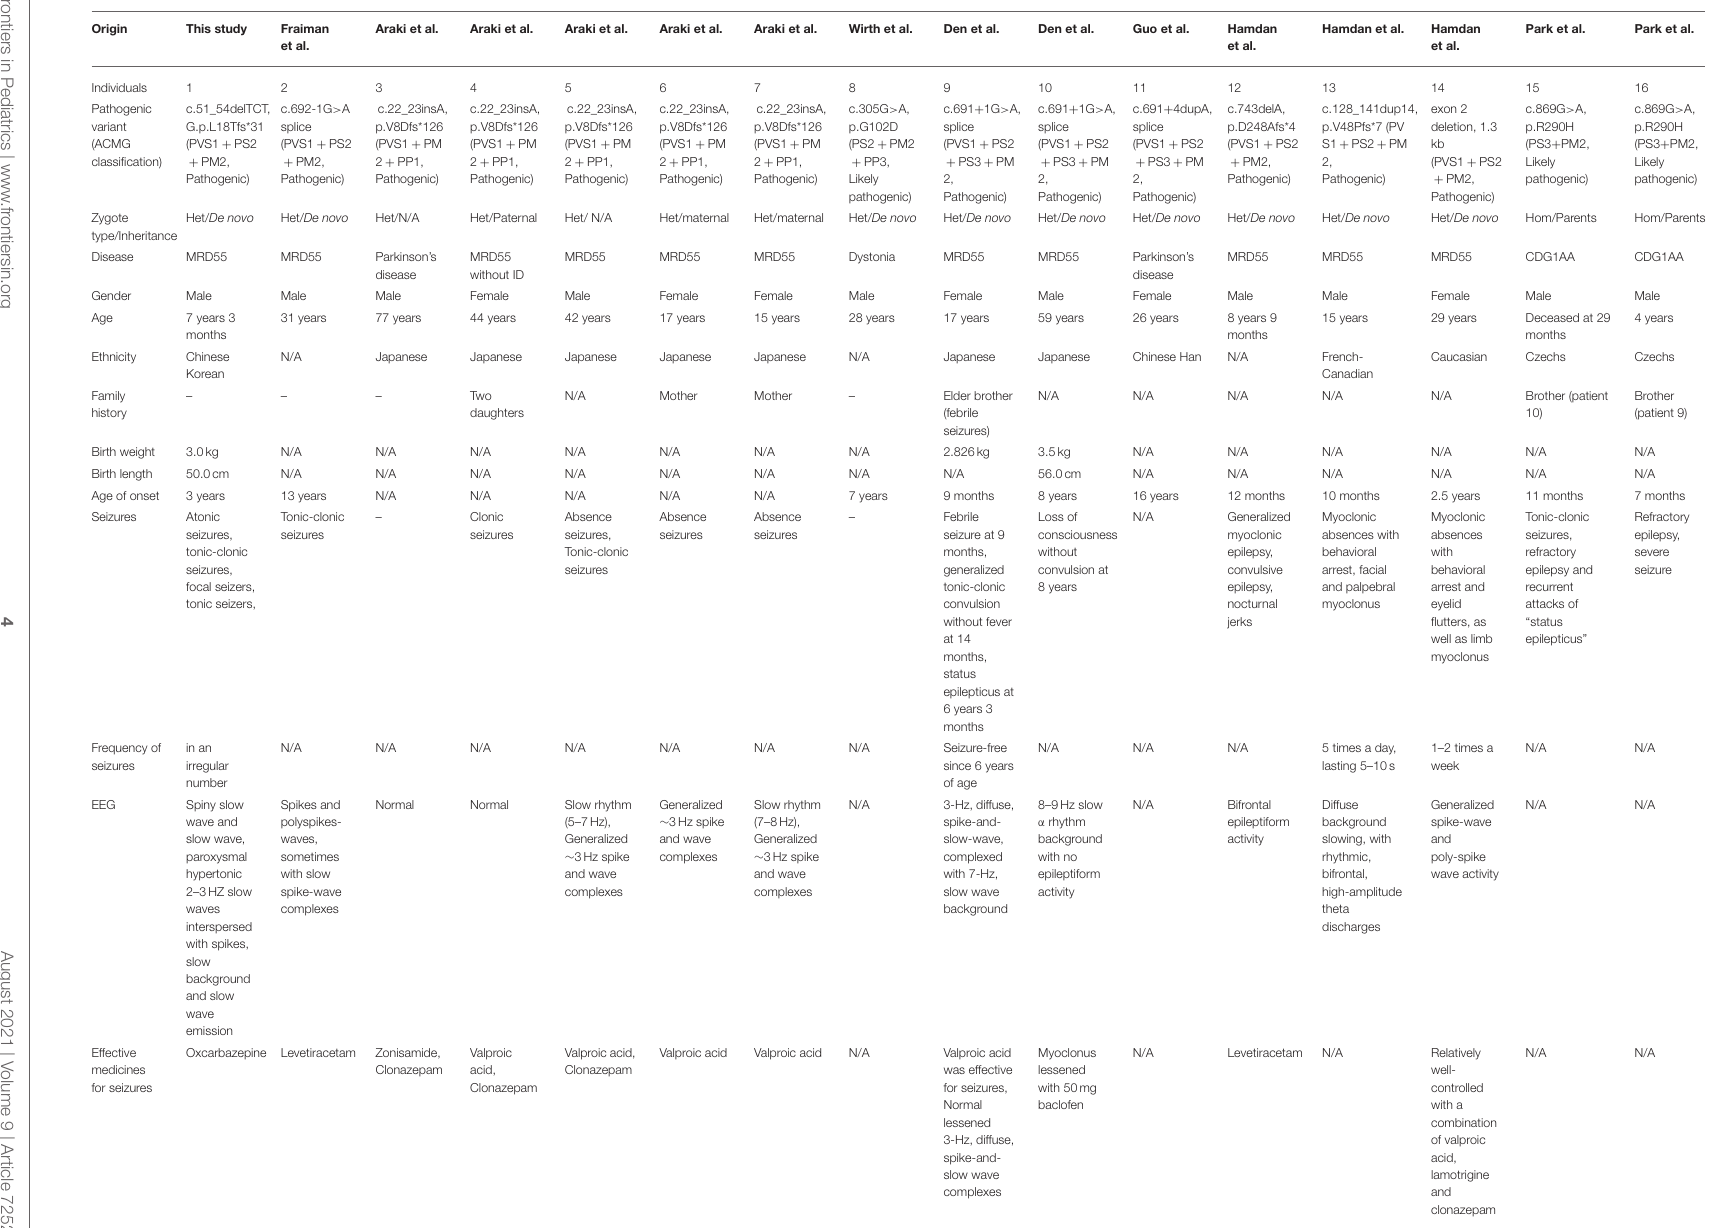
TABLE 1 | Clinical features of individuals with NUS1 pathogenic